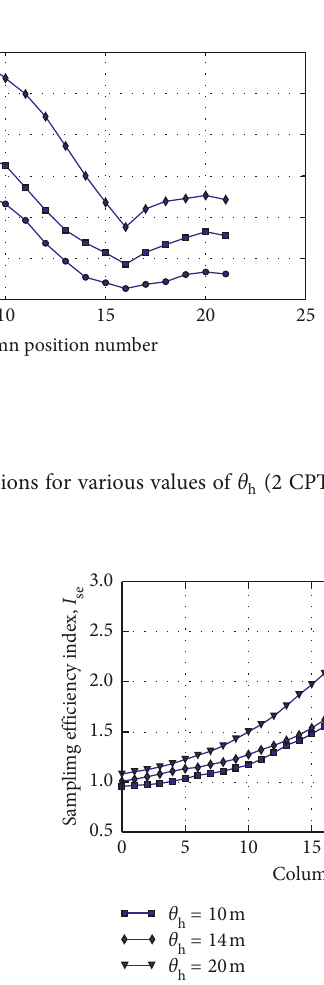
Figure 12: Sampling efficiency indices at different sampling lo- (2 CPT h cations for various values of θ